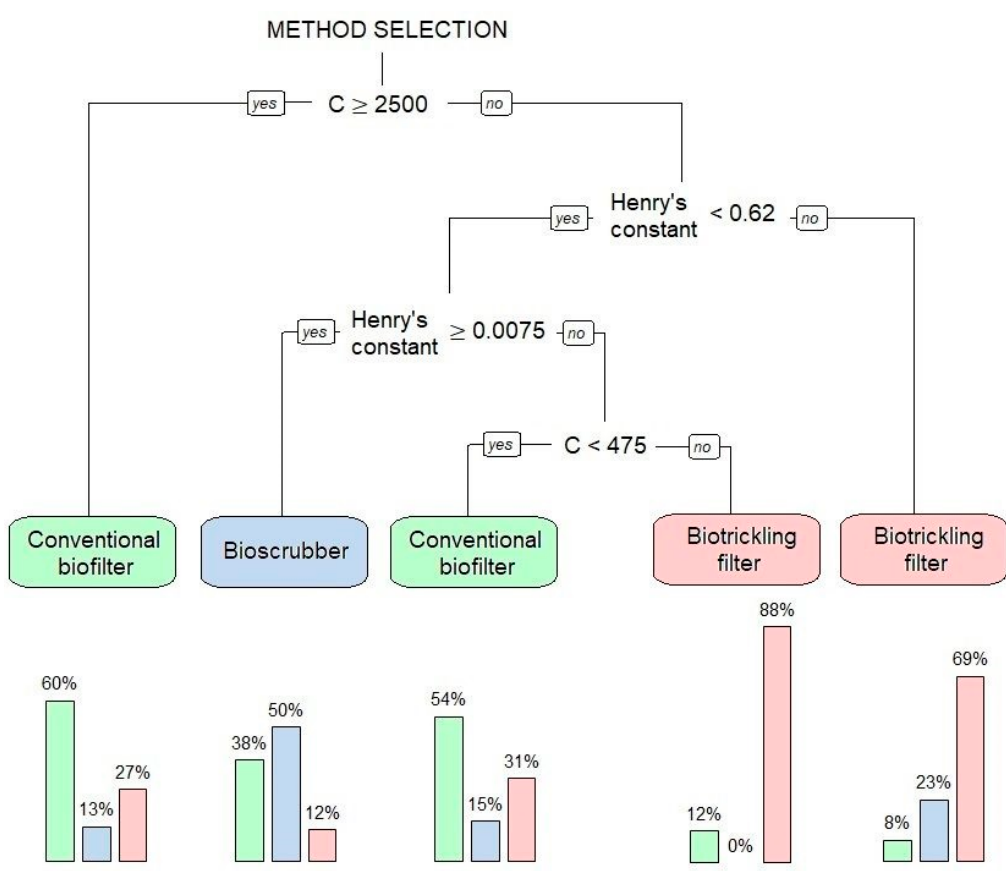
Figure 5. Developed decision tree for the selection of the most suitable biological treatment method (C—inlet concentration, mg · m − 3 ; Henry’s constant, mol · m − 3 · Pa − 1 ).